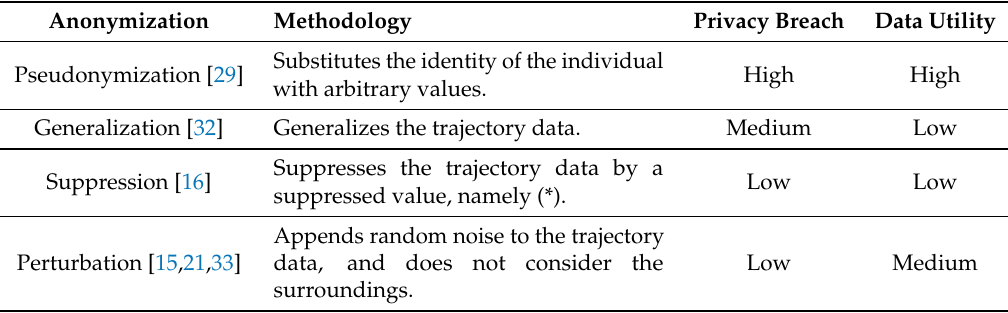
Table 1. Summary of the anonymization